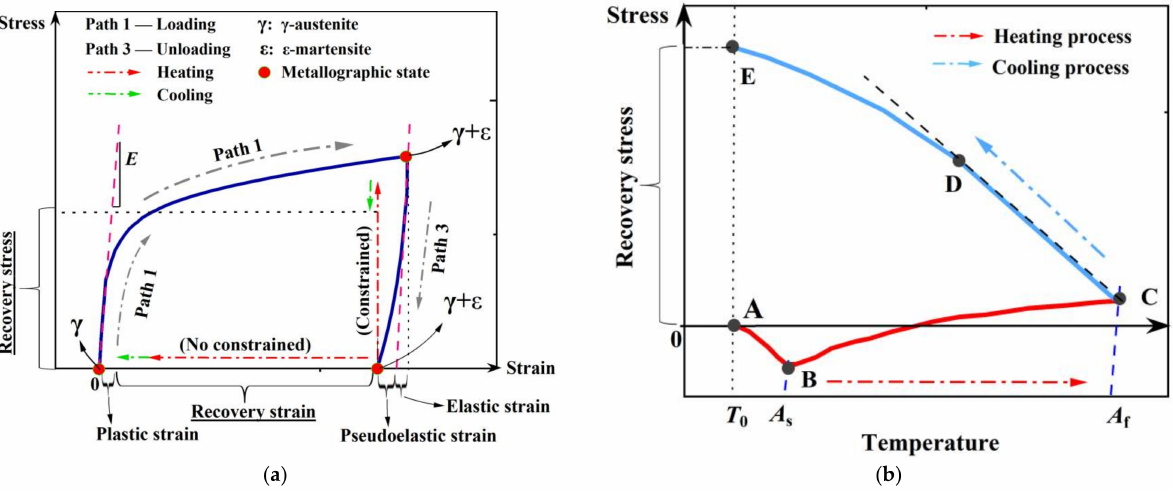
Figure 7. Schematic diagram of ( a ) activation process of shape recovery property, and ( b ) generation of recovery